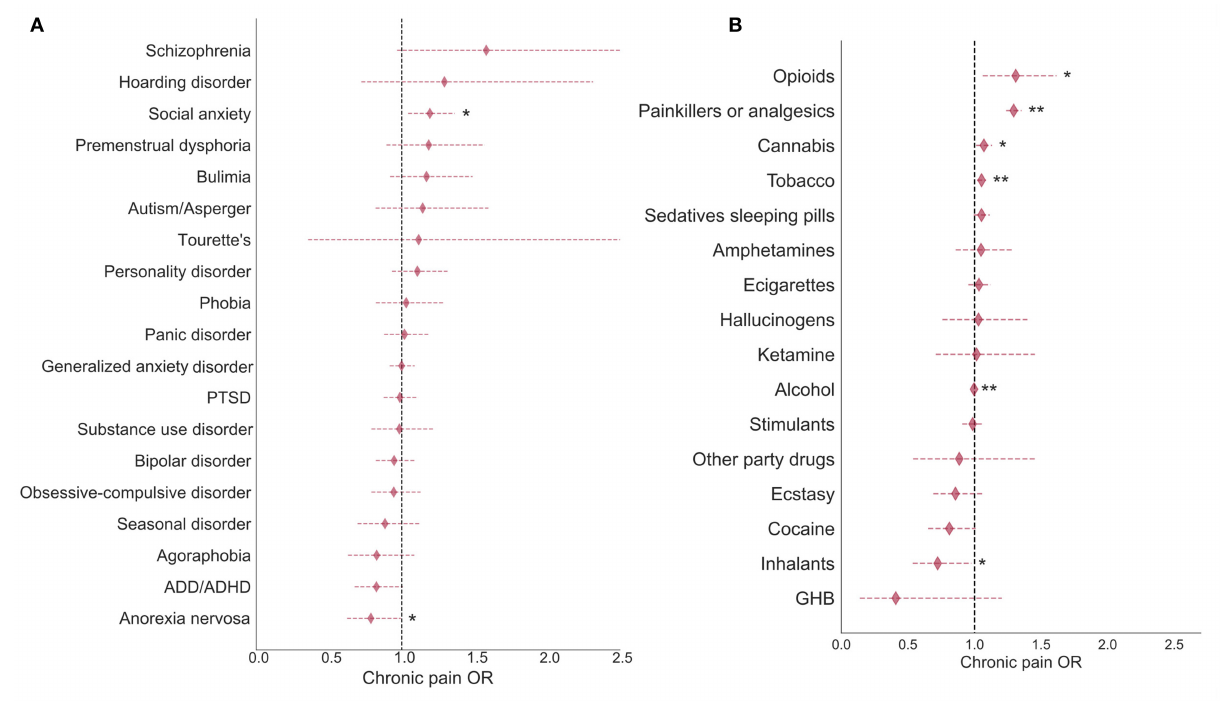
heterogeneity, high comorbidity and wide individual variation commonly observed in psychiatric